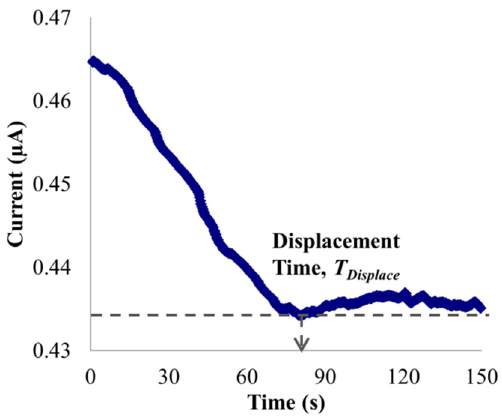
Figure 2. Current-time response for 0.475 mM NaHCO 3 (95% concentration of the measurement solution) displacing 0.5 mM NaHCO 3 (measurement solution).